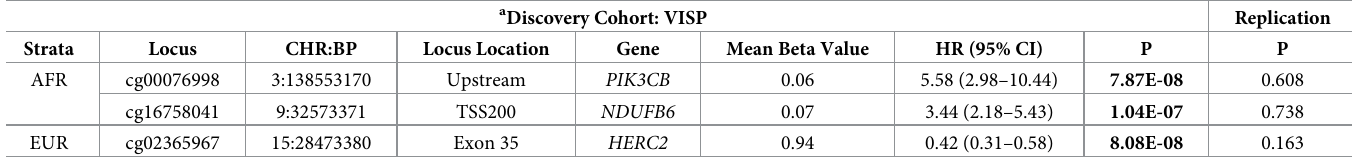
Table 3. Significant methylation loci associated with time to VISP composite vascular endpoint (p � 1.06e-07).